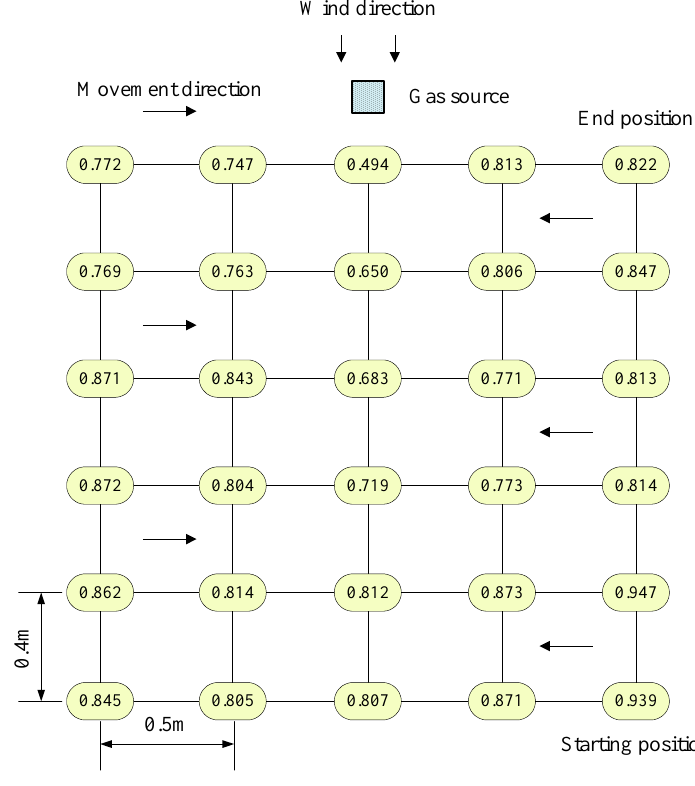
Figure 10. Odor concentration distribution in the experimental